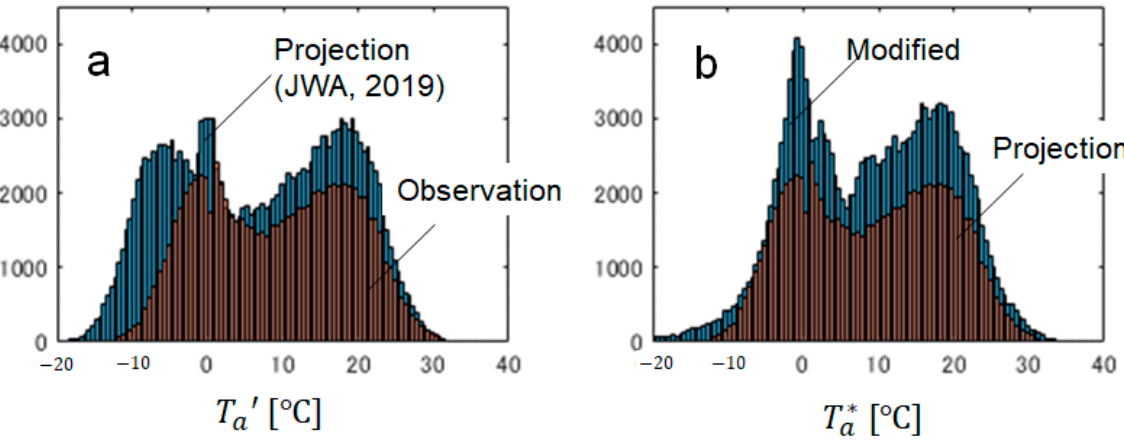
Figure 2. Histograms of hourly outdoor temperatures in Sapporo: ( a ) observation and prediction for 1981–1999 and ( b ) projection and modification in this study for 2076–2095. Table 1. Summary of outdoor temperature T a and degree days D d for the present (2001–2020) and future (2076–2095) in Sapporo and Tokyo, Japan. Future data were modified from JWA (2019),